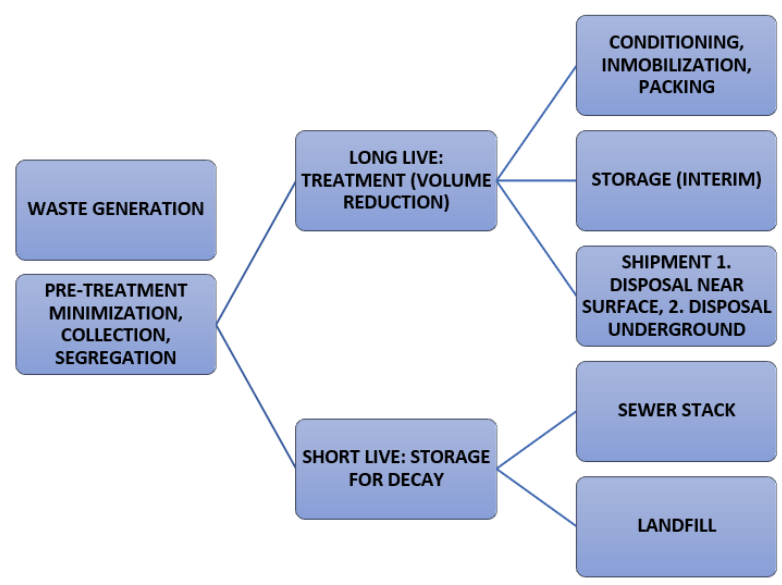
Figure 1. Radioactive waste management chart.